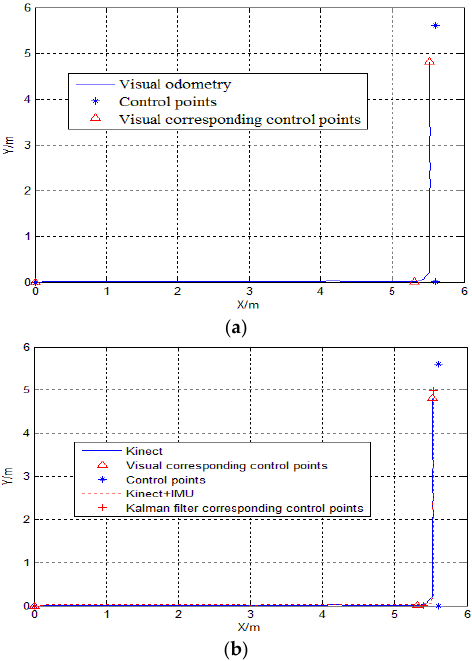
Figure 4. ( a ) Kinect positioning results; ( b ) Comparison of Kalman filter positioning trajectory.